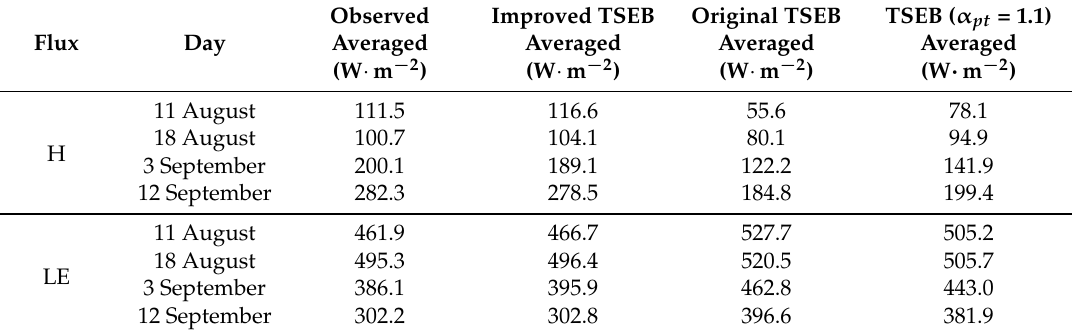
Table 4. Statistics of energy fluxes from improved TSEB and original TSEB ( α pt = 1.3 and